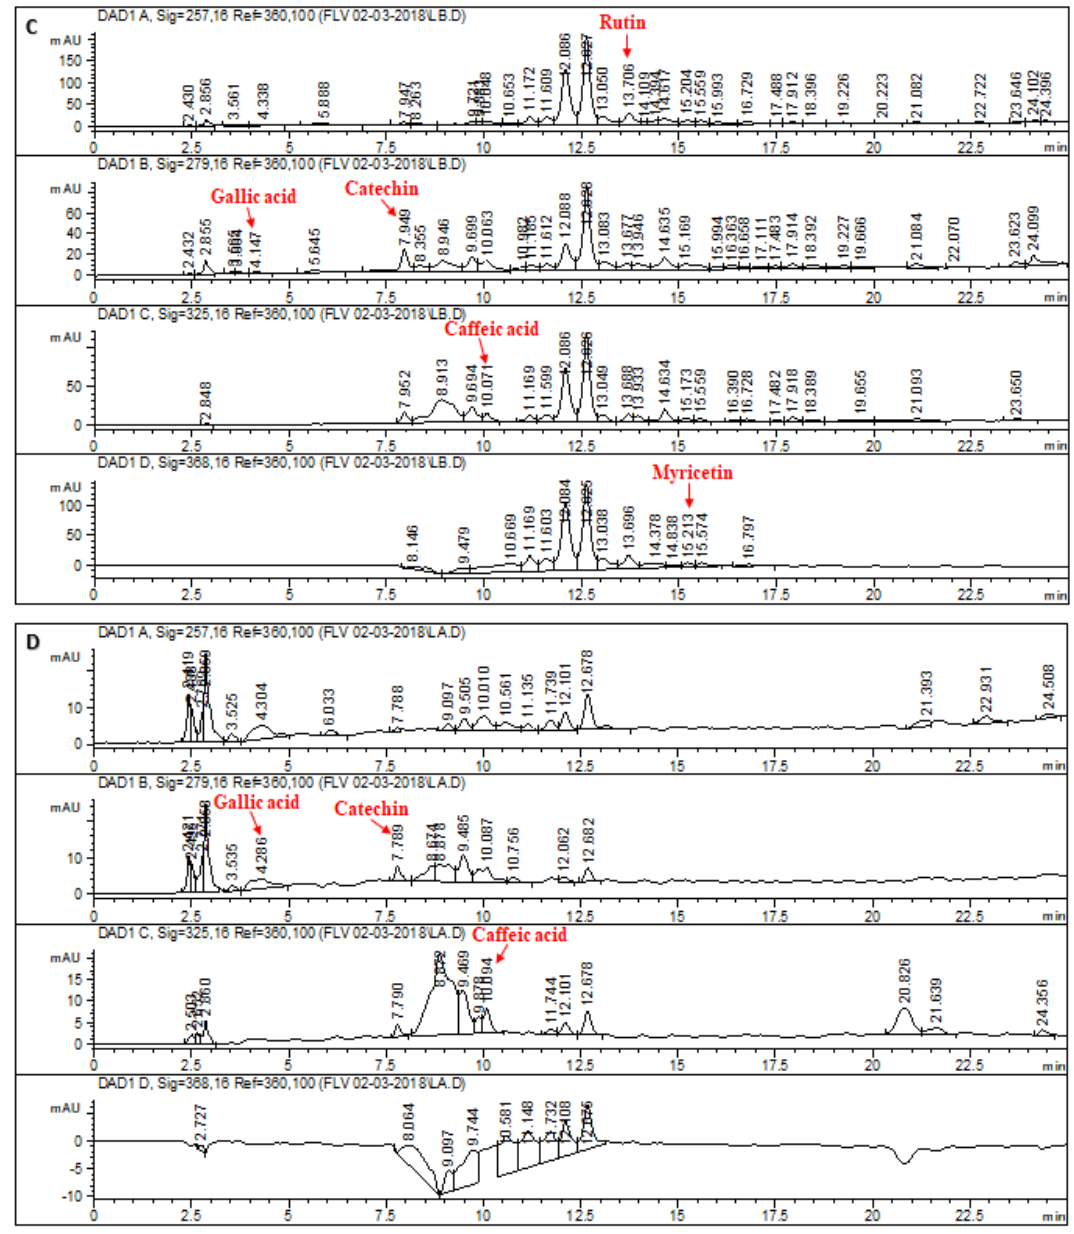
Figure 2. HPLC–DAD chromatogram of ( A ) LCM, ( B ) LCE, ( C ) LCB, ( D ) LCA at varying wave- lengths. Signal 1: 257λ, signal 2: 279λ, signal 3: 325λ, signal 4: 368λ. Conditions: Mobile-phase A—